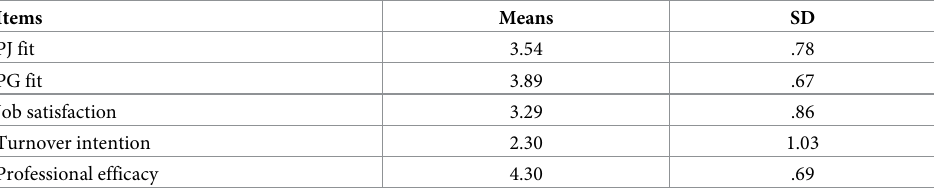
Table 2. Average scores of PJ fit, PG fit, job satisfaction, turnover intention and professional